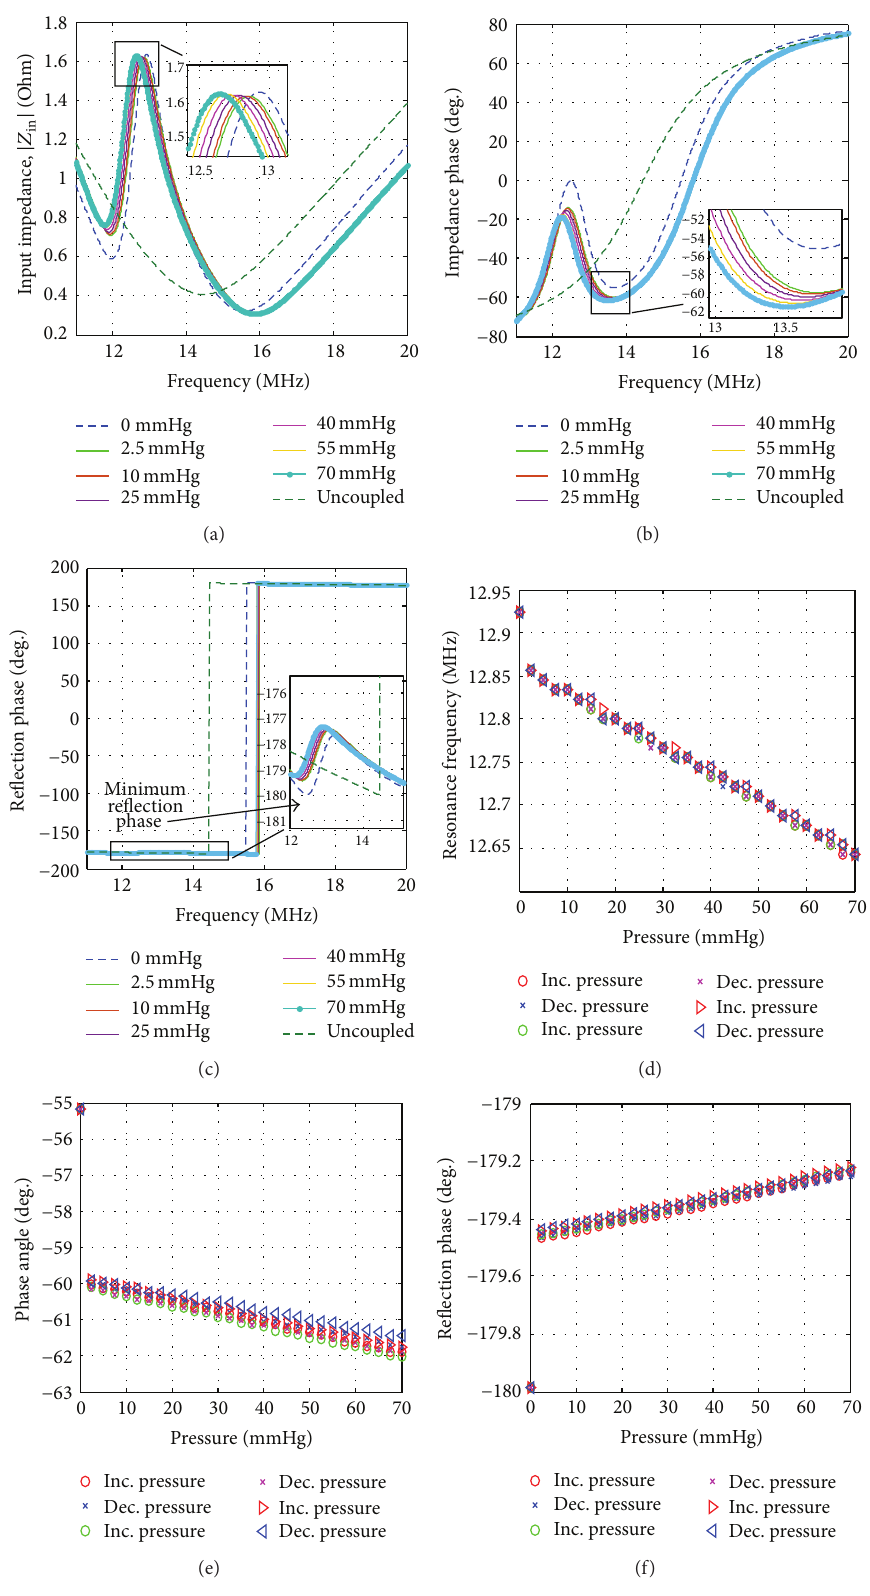
Figure 5: Measurement results obtained from sensor A. (a) Magnitude and (b) phase angle of the reader antenna’s input impedance. (c) Reflection phase of the sensor as a variable load. (d) Shift in the resonance frequency of the sensor as a function of pressure. (e) Phase dip variation. (f) Phase shift versus applied